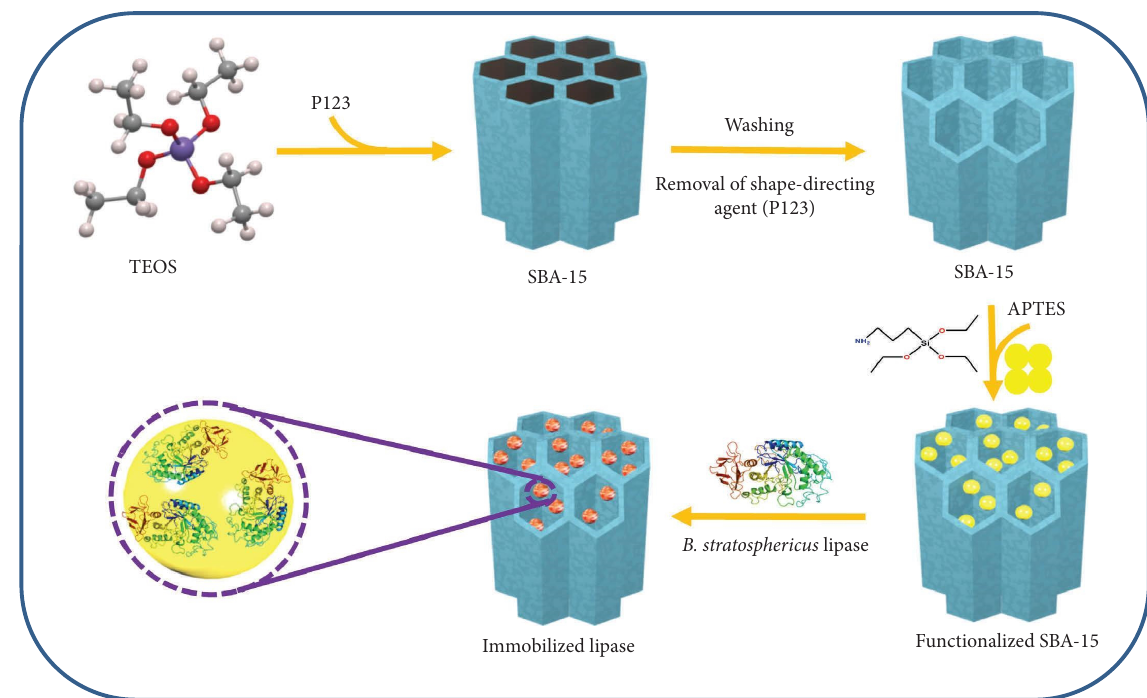
Figure 1: Steps for Bacillus stratosphericus lipase immobilization on the prepared NH